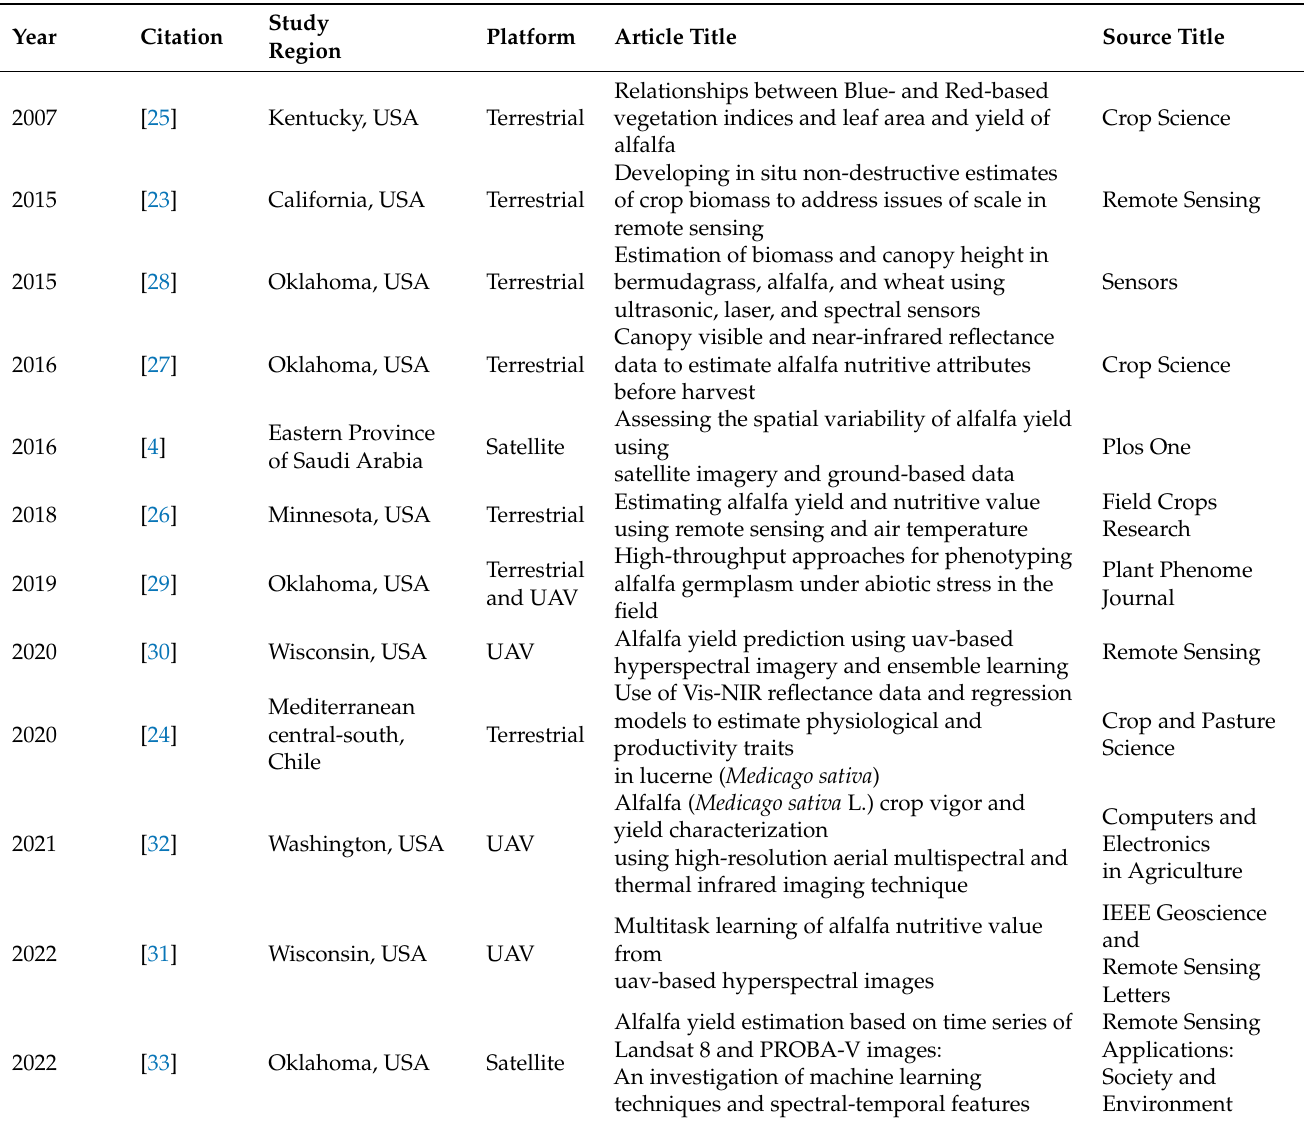
Table 1. State-of-the-art of remote sensing for assess alfalfa production and